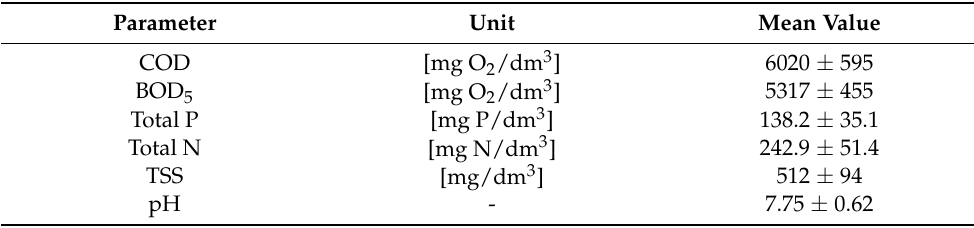
Table 1. Profile of the raw influent fed into the anaerobic reactors.